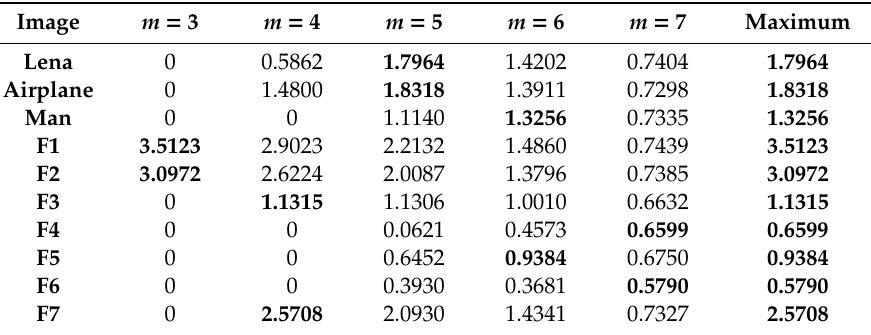
Figure 7. Seven tested images selected from the BOWS-2 database. Table 1. Maximum PER of ten tested images under di ff erent values of m